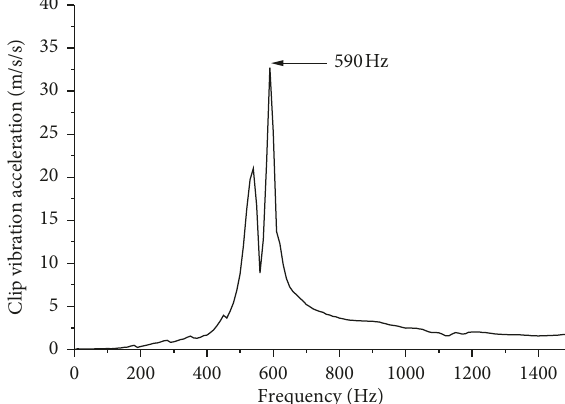
Figure 16: Installation modal frequency of the ω -type clip.